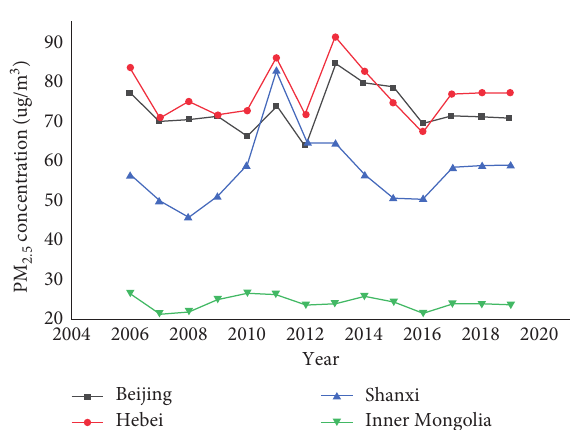
Figure 4: The Gini coefficients and prediction values of North China.